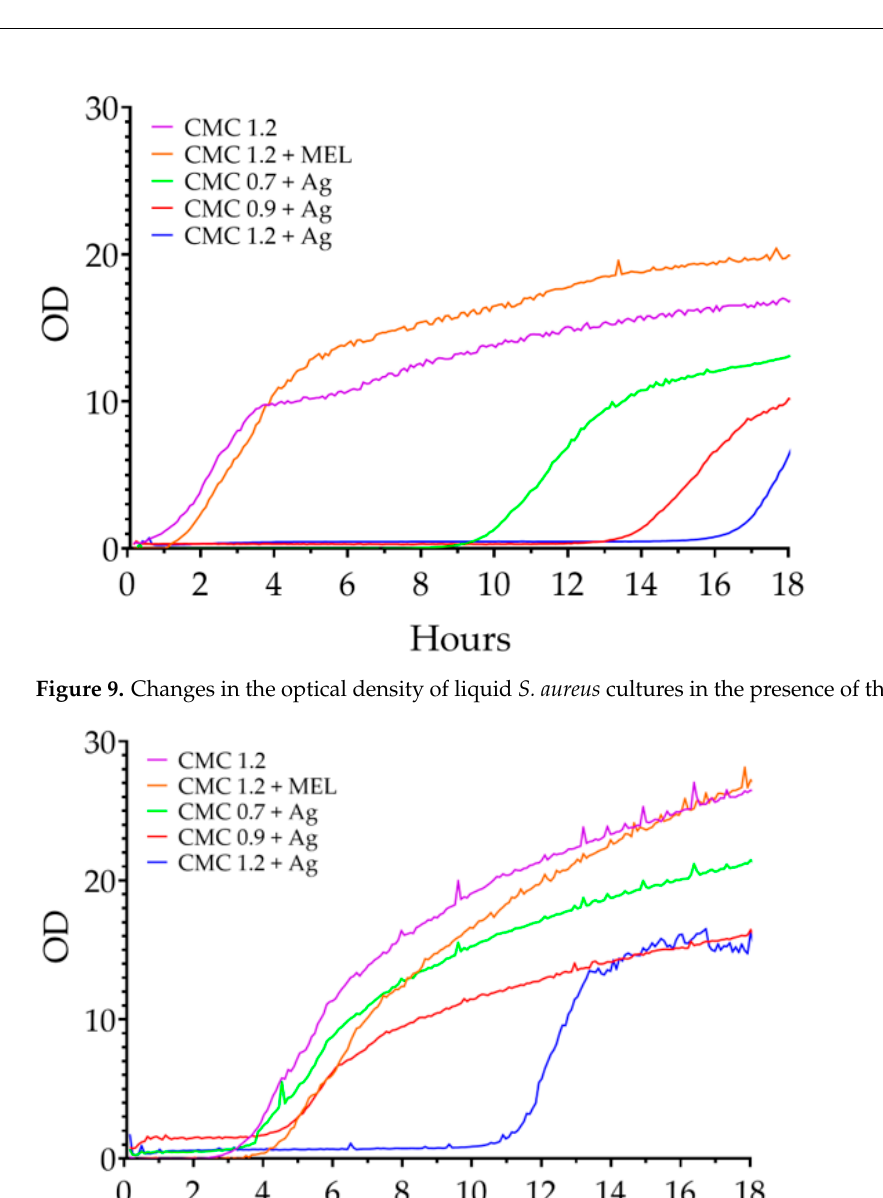
Figure 10. Changes in the optical density of liquid C. albicans cultures in the presence of the films tested.